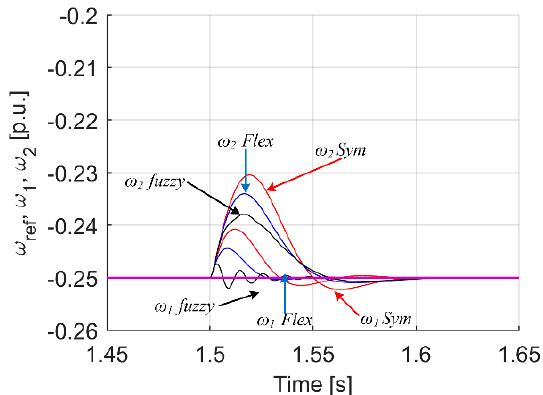
Figure 10. Transients of difference between motor and reference speed under torque load change. Figure 11. Transients of difference between motor and load speed under load occurrence. Looking at Figure 11, it can be seen that the smallest maximum difference between the speed ω 1 and ω 2 is given by the Flex tuning of the PI controller. A slightly larger dif- ference is offered by the fuzzy regulator, and the smallest, although the differences are minimal, is provided by the tuned Flex regulator. Later in Figures 12–14, the transients involved by change of reference speed are shown. Here, too, we can see analogous behav- ior of a bend, but the time of the dynamic state is relatively longer, so the real differences between the systems are also slightly more significant.